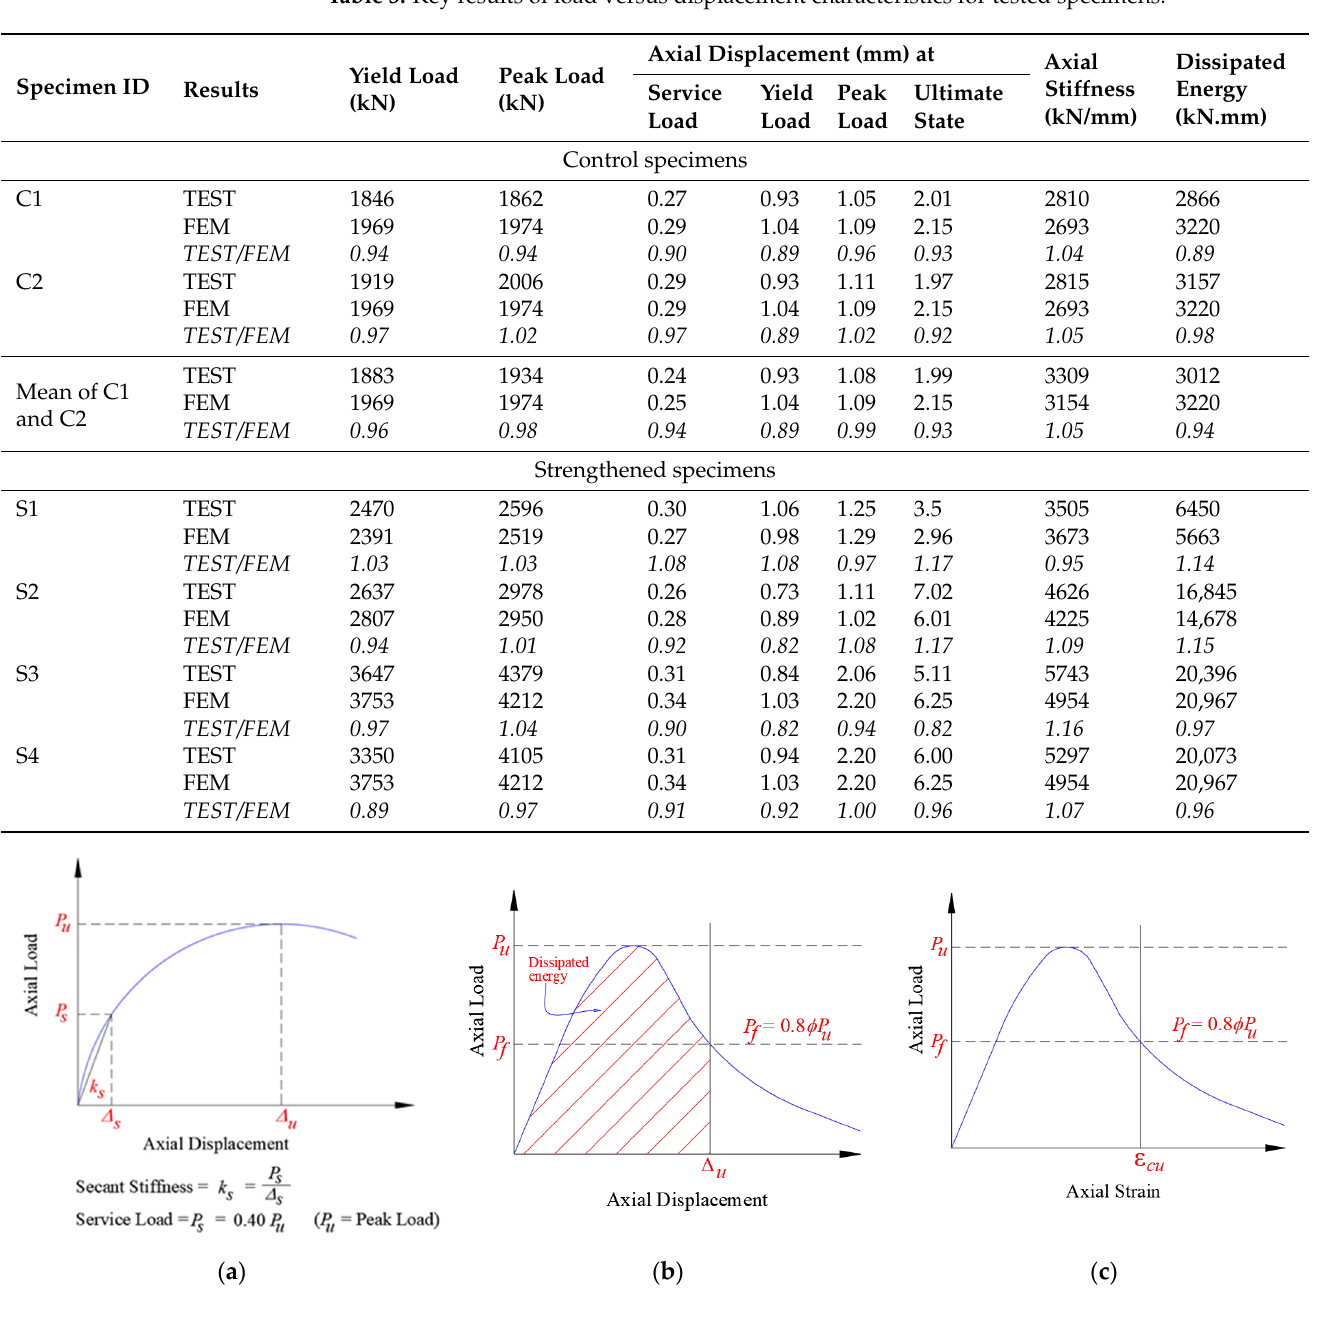
Table 3. Key results of load versus displacement characteristics for tested specimens.